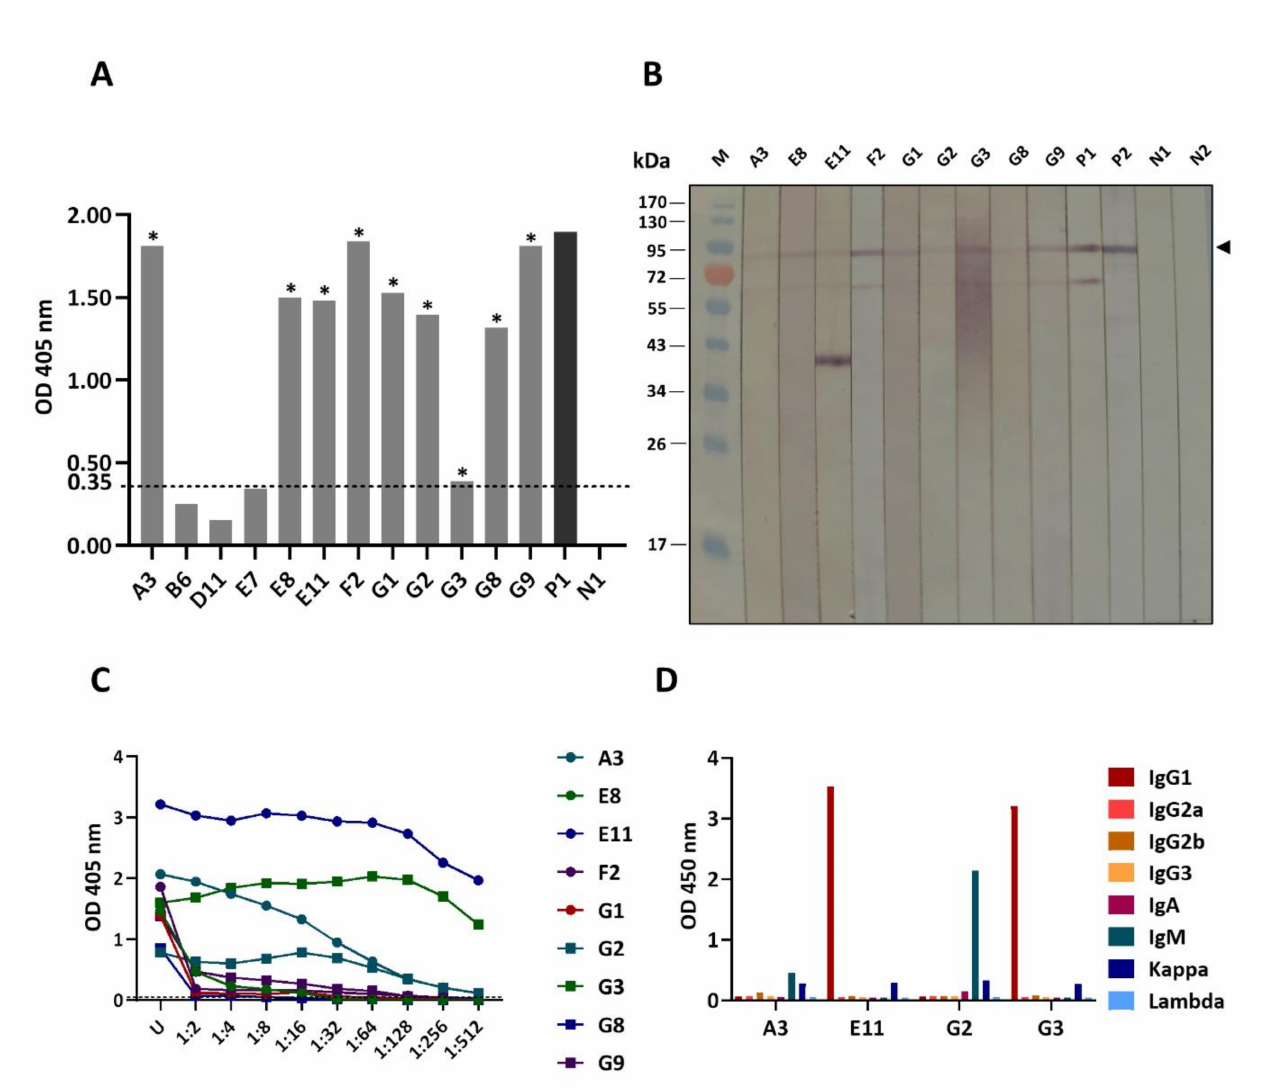
Figure 2. Binding of monoclonal antibodies (mAbs) in culture fluids of different hybridoma clones to rS1 and titers and isotypes of the mAbs secreted by the selected hybridomas. ( A ) Indirect ELISA OD 405 nm of mAbs in individual hybridoma culture fluids to the rS1. *, the clone that gave OD 405 nm ≥ 0.35 (arbitrarily cut-off level), which was selected for further testing. P1, mouse immune serum (1:50,000) to rS1 (IS) as positive binding control; N1, SP2/0-Ag14 spent medium as negative binding control. Broken line, cut-off OD. ( B ) Binding of the mAbs of the selected